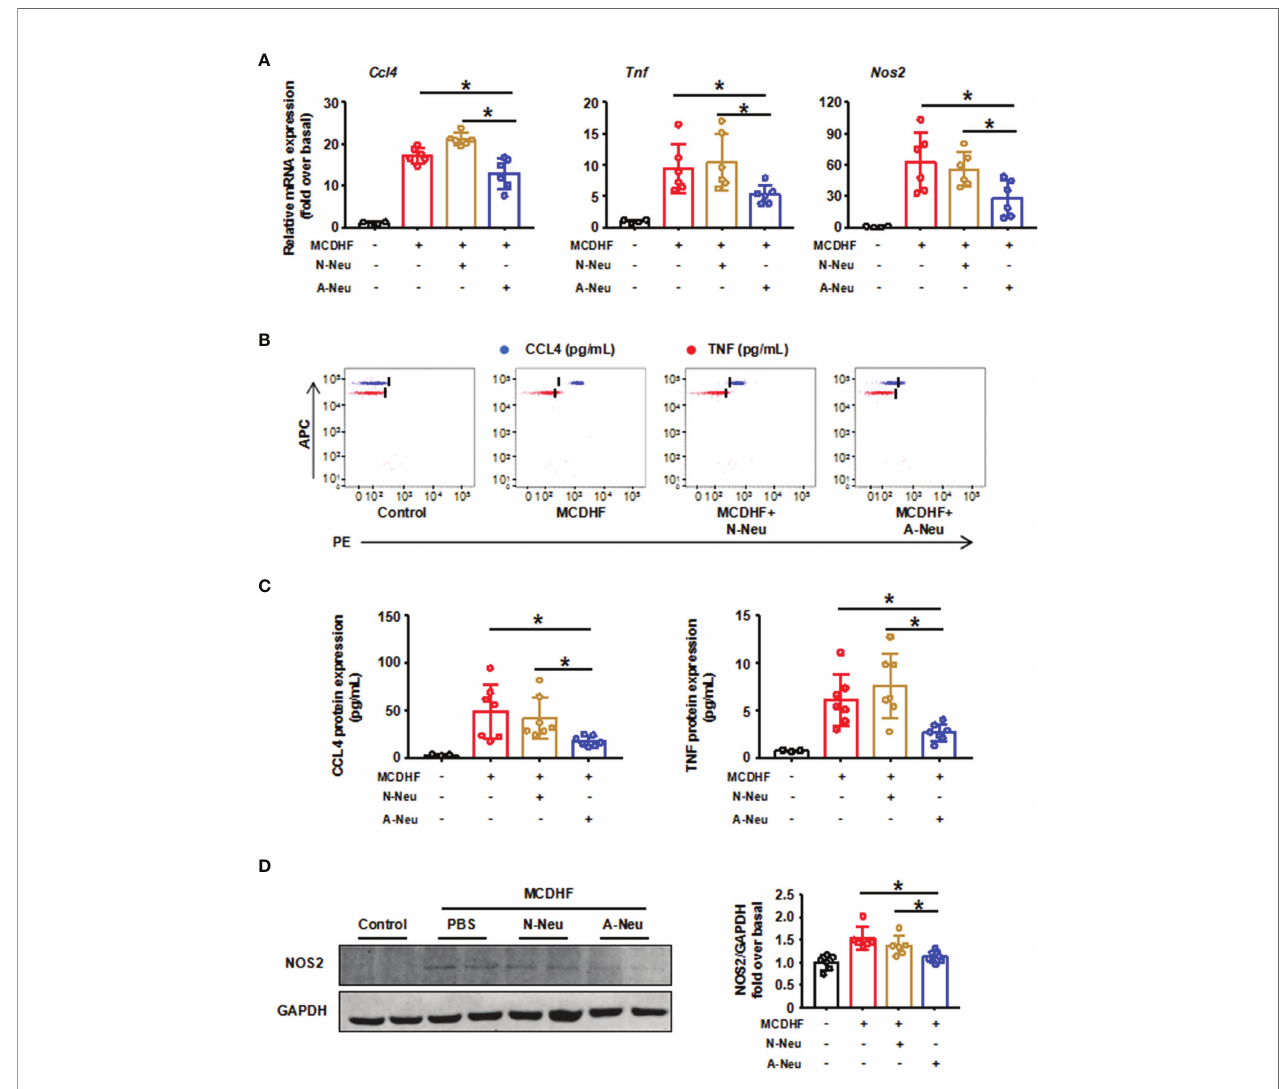
FIGURE 2 | A-Neu inhibited the expression ofpro-in fl ammatorycytokines in the injured liver of mice induced byMCDHF. (A) N-Neu or A-Neu were injected into mice 2 weeks after MCDHF diet, andthe livers were collected at 4 daysafter injection. Hepatic expressions of Ccl4 , Tnf and Nos2 transcripts weremeasured byRT-qPCR, presentedrelative to Gapdh , (control group, n=4; MCDHF group,n=6). The representative scatter plot of CBA, as shownin (B) , and the two bead populationsrepresented CCL4and TNFrespectively. (C) Showed the quanti fi cation of theseprotein concentrations (control group, n=3; MCDHF group, n=7). (D) NOS2 protein levelsin indicated groups were examined by WB(n=6). The results were presented as mean ± SD.One-way ANOVA was used. *P < 0.05. MCDHF,methionine-choline-de fi cient and high-fat diet; A-Neu,activated neutrophil; N-Neu,non-activated neutrophil;Ccl4, C-C chemokine motifligand4; Tnf, tumor necrosisfactor; Nos2, nitric oxidesynthase